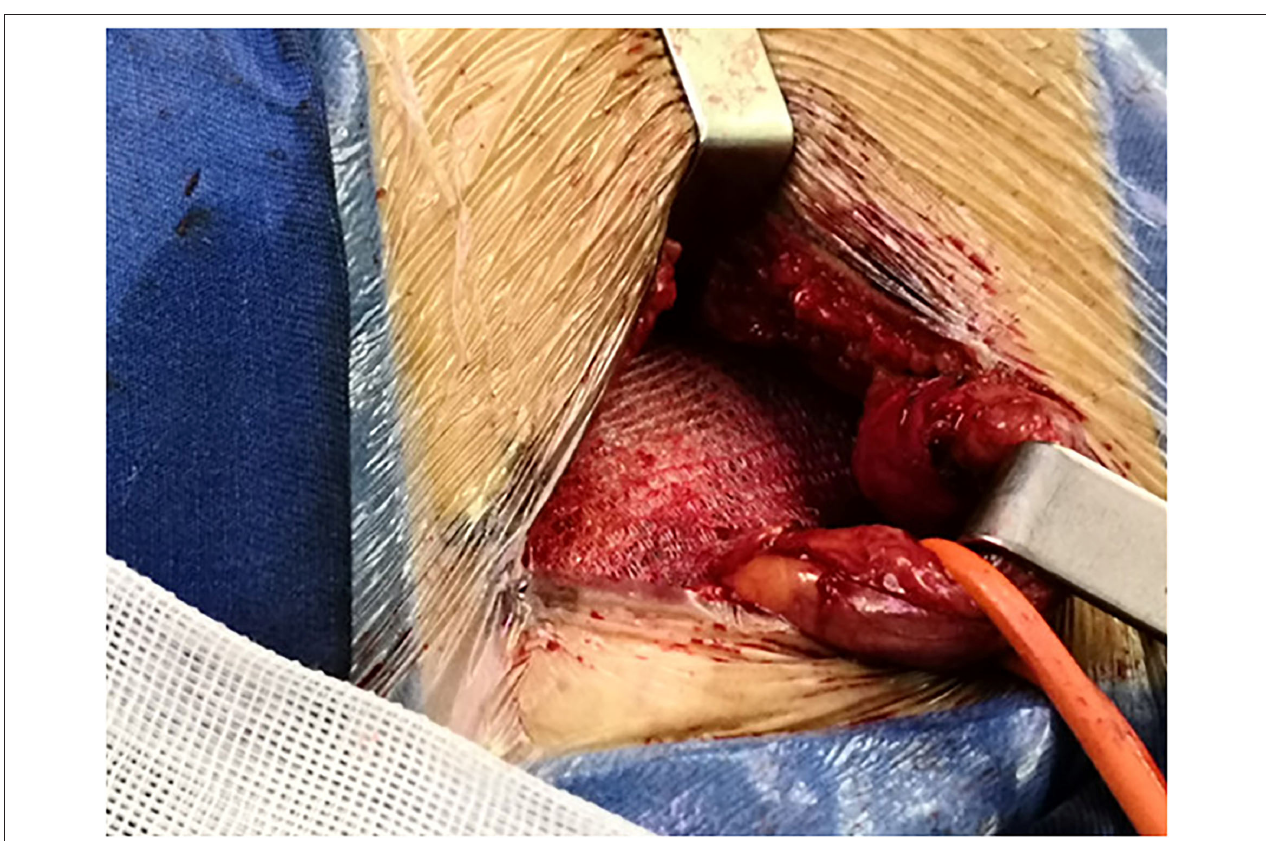
FIGURE 3 | The mesh covers all the defects.